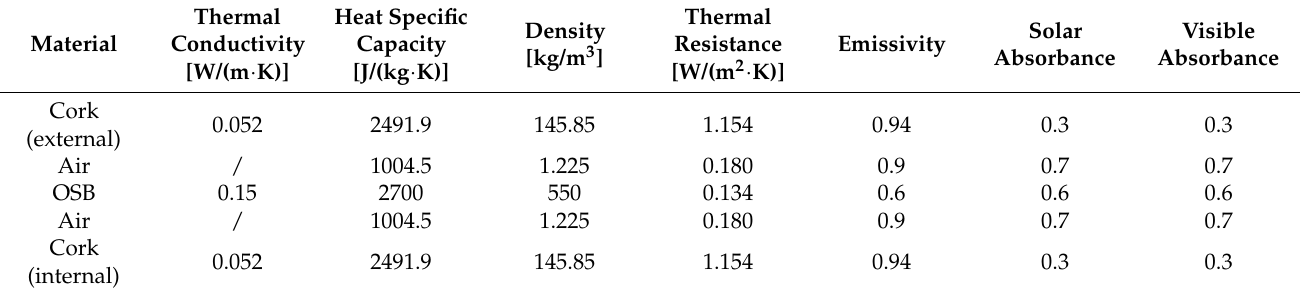
Table 2. Thermo-physical and optical properties of the materials used for the SuberWall panel